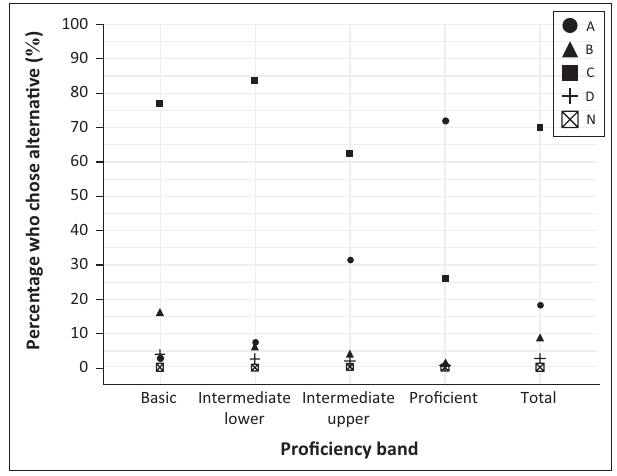
FIGURE 12: For a question requiring proportional reasoning, the proportions of students who chose each alternative answer, for the total cohort and for each proficiency band.